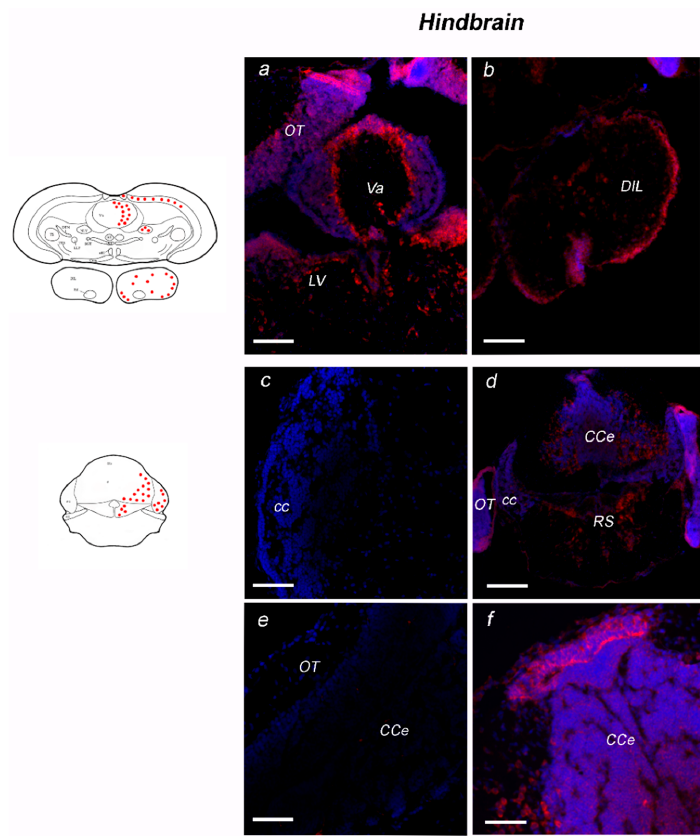
Figure 7. Expression of NT-6 mRNA in transverse section of hindbrain of adult N. furzeri. On the left side, schematic drawings of N. furzeri brain, with red dots indicating NT-6 mRNA distribution over the different brain areas. ( a ) Intense staining in the cells of caudal part of PGZ, and along the margin between OT and TL. Positivity in neurons of Purkinje layer of Va and in neurons of LV. ( b ) Positive neurons widespread over the central nucleus and dorsal hypothalamus of the most caudal part of DIL. ( c ) Sense probe staining in the cerebellar crista. ( d ) Intense staining in neurons of Purkinje, in neurons of RS. ( e ) Sense probe staining in the OT and CCe. ( f ) Intense staining labeling in the most upper portion of CCe (arrow) and in neurons of Purkinje layer of CCe. Scale bars: ( a , b , d ) 50 µm; and ( c , e , f ) 100 µm. Abbreviations: CCe, corpus of cerebellum; cc, cerebellar crista, DIL, diffuse inferior lobe of hypothalamus; LV, nucleus of lateral valvula; OT, optic tectum; PGZ, periventricular grey zone; RS, superior reticular formation; TL, longitudinal tori; Va, valvula of cerebellum.